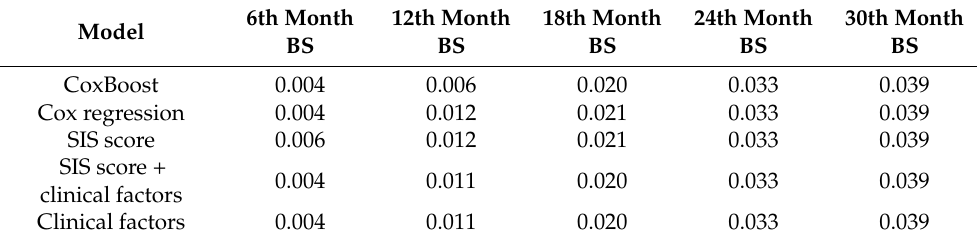
Table 5. The calibration (Brier score) for each model validated at each half year of follow-up. Model